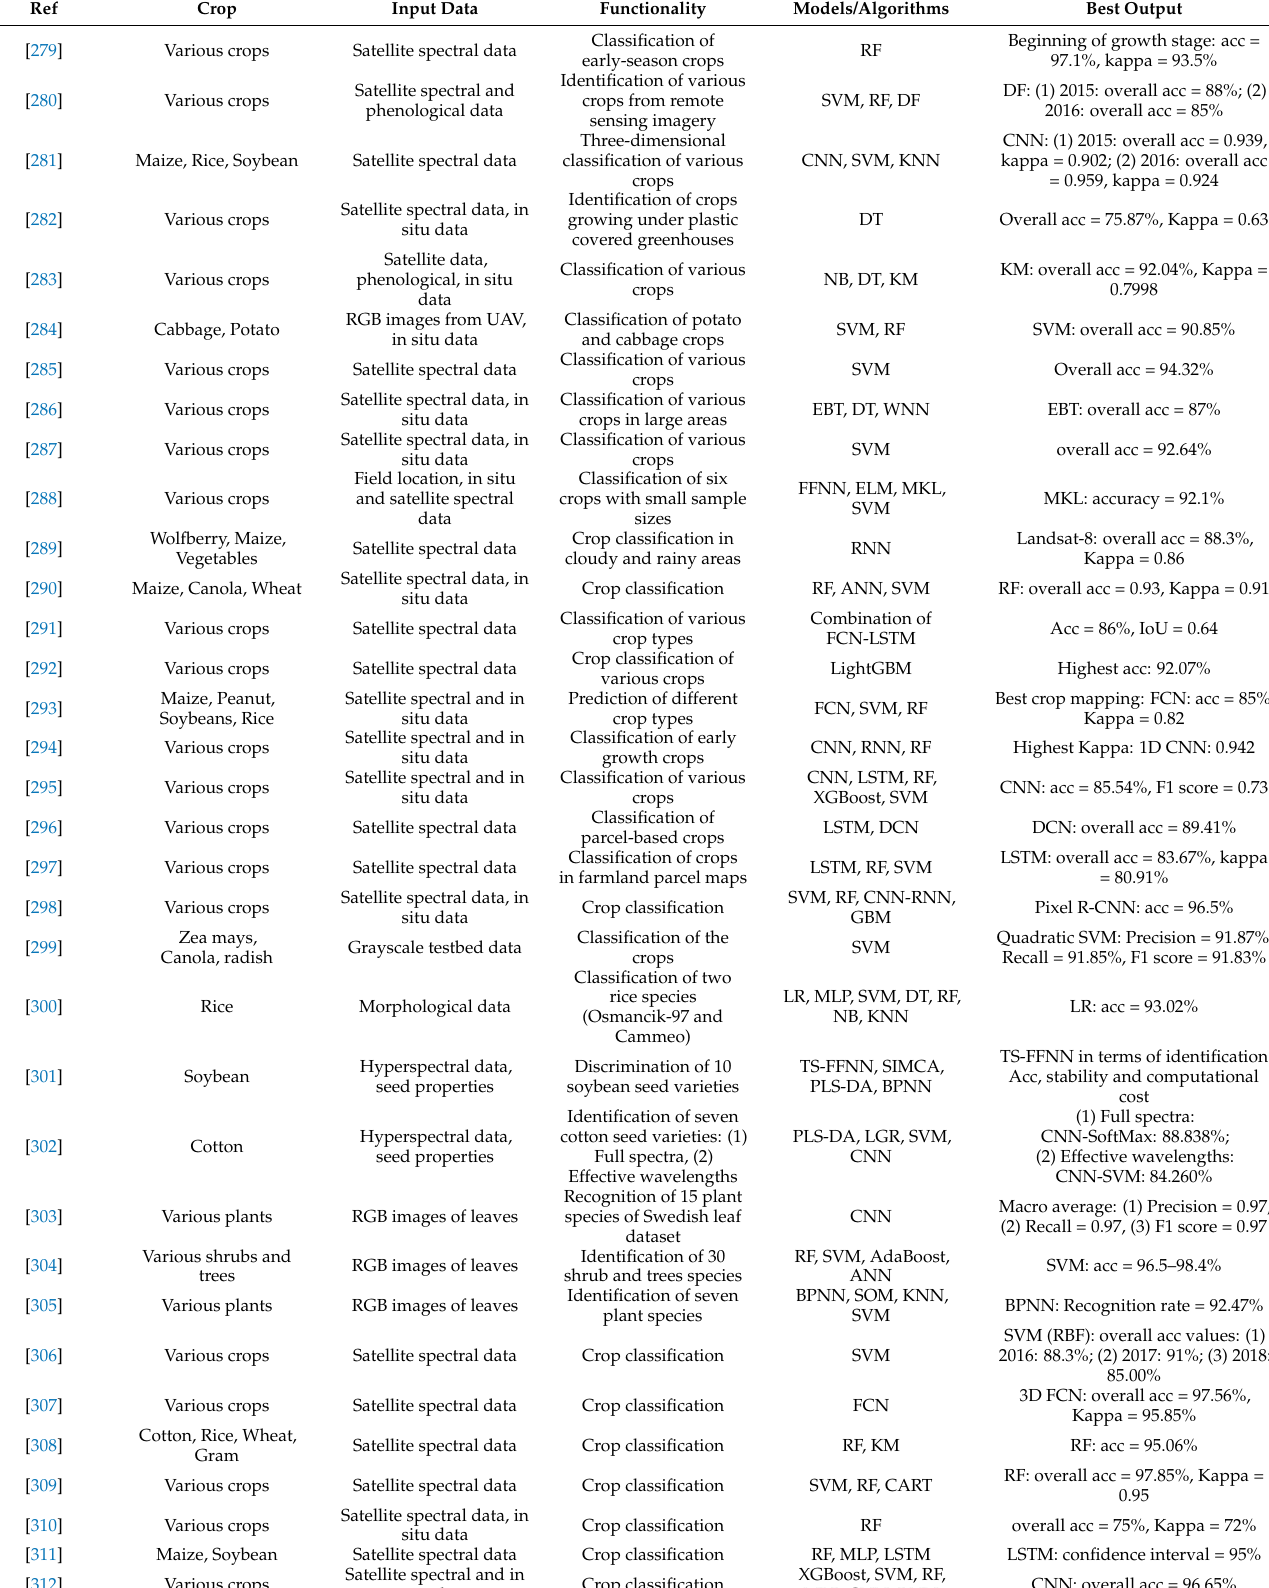
Table A4. Crop Management: Crop